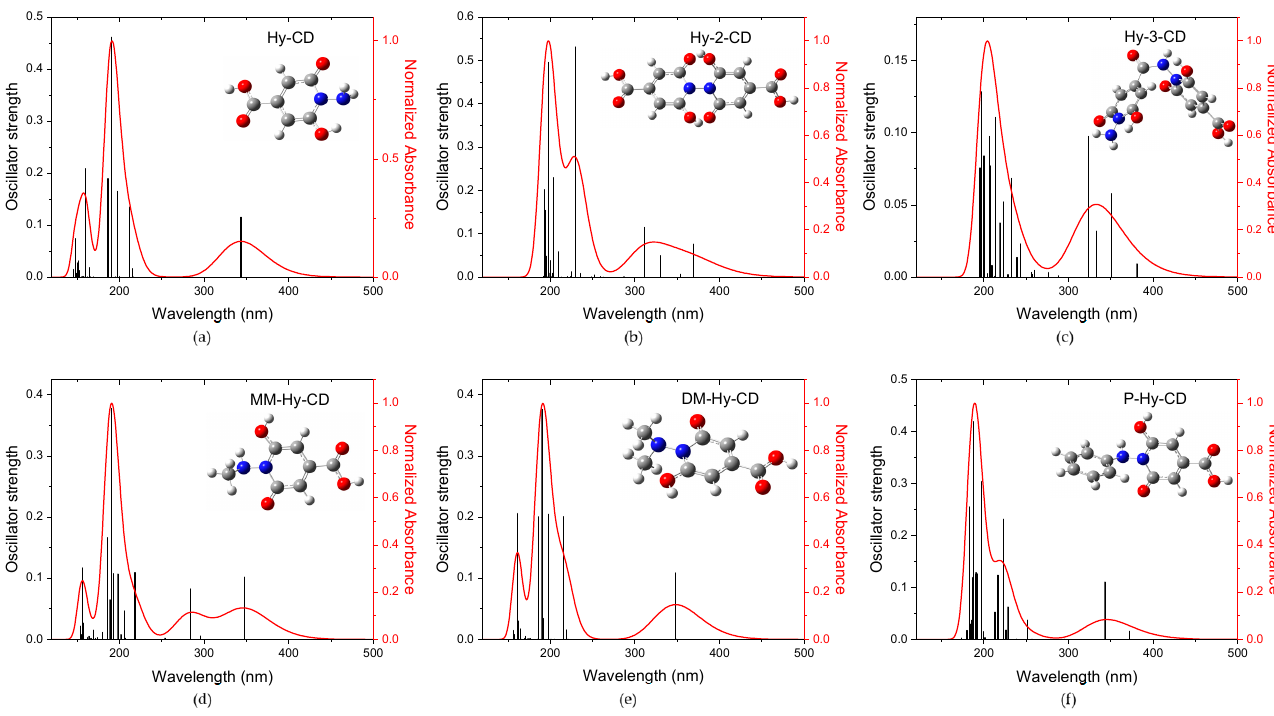
Figure 6. Simulated absorbance spectra and oscillator strength of pyridinone molecules. The insets report the ball-and-stick representation of the structures (H atom—white sphere, C atom—grey sphere, N atom—blue sphere, O atom—red sphere). ( a ) Hy-CD, ( b ) Hy-2-CD, ( c ) Hy-3-CD, ( d ) MM-Hy-CD, ( e ) DM-Hy-CD, ( f ) P-Hy-CD.